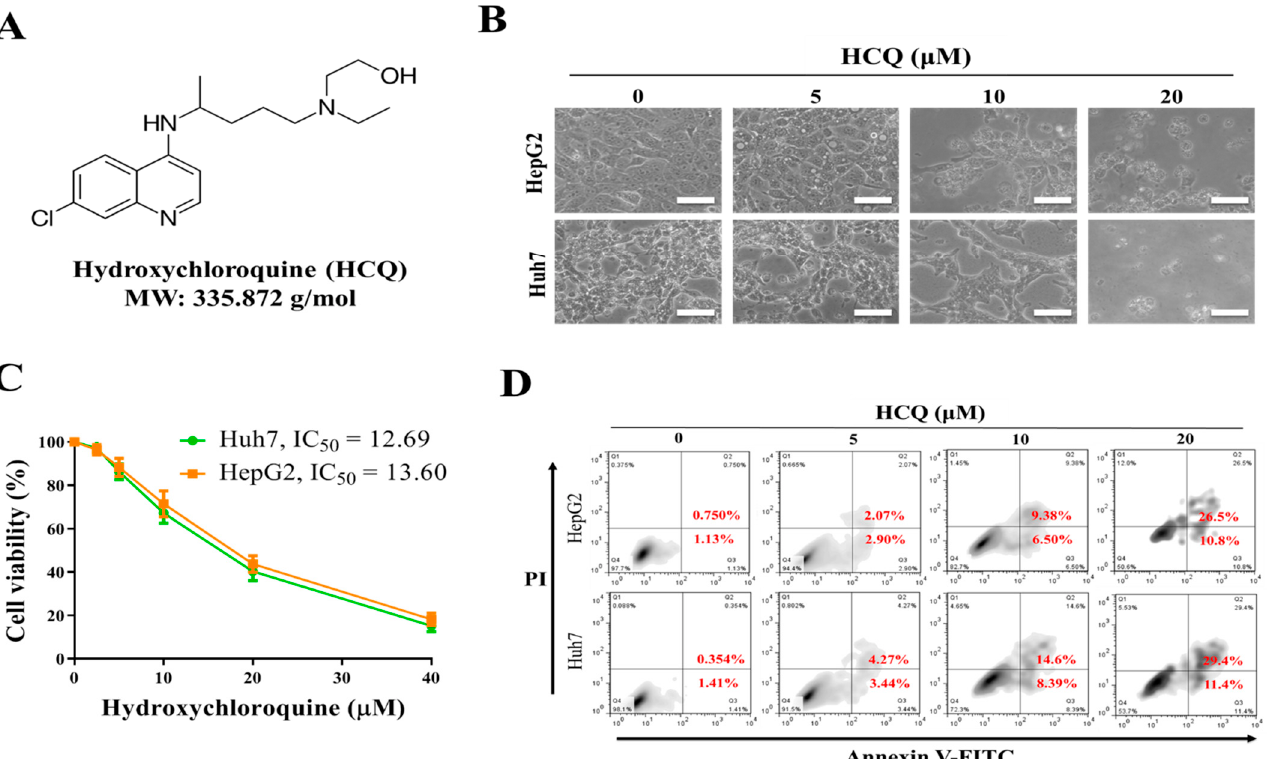
Figure 2. The effect of hydroxychloroquine (HCQ) on cell proliferation and viability of HCC cell lines. ( A ) The chemical structure of HCQ. ( B ) Effect of HCQ on the morphology of the HCC cells (Huh7 and HepG2) shown through the image of the cells taken under the phase-contrast microscopy image at × 200 magnification. Scale bar 100 µ m. ( C ) Cytotoxic effect HCQ (IC 50 ): Huh7 and HepG2 cells were treated for 96 h with increasing concentration of HCQ (2.5 to 40 μ M). SRB assay was performed to analyze cellular viability, DMSO was used as the negative control. ( D ) Apoptosis rate (%) of HCC cells after HCQ treatment was determined using flow cytometry; representative images were taken from HCQ-treated and non-treated control cells stained with annexin V/propidium iodide (magnification ×100).